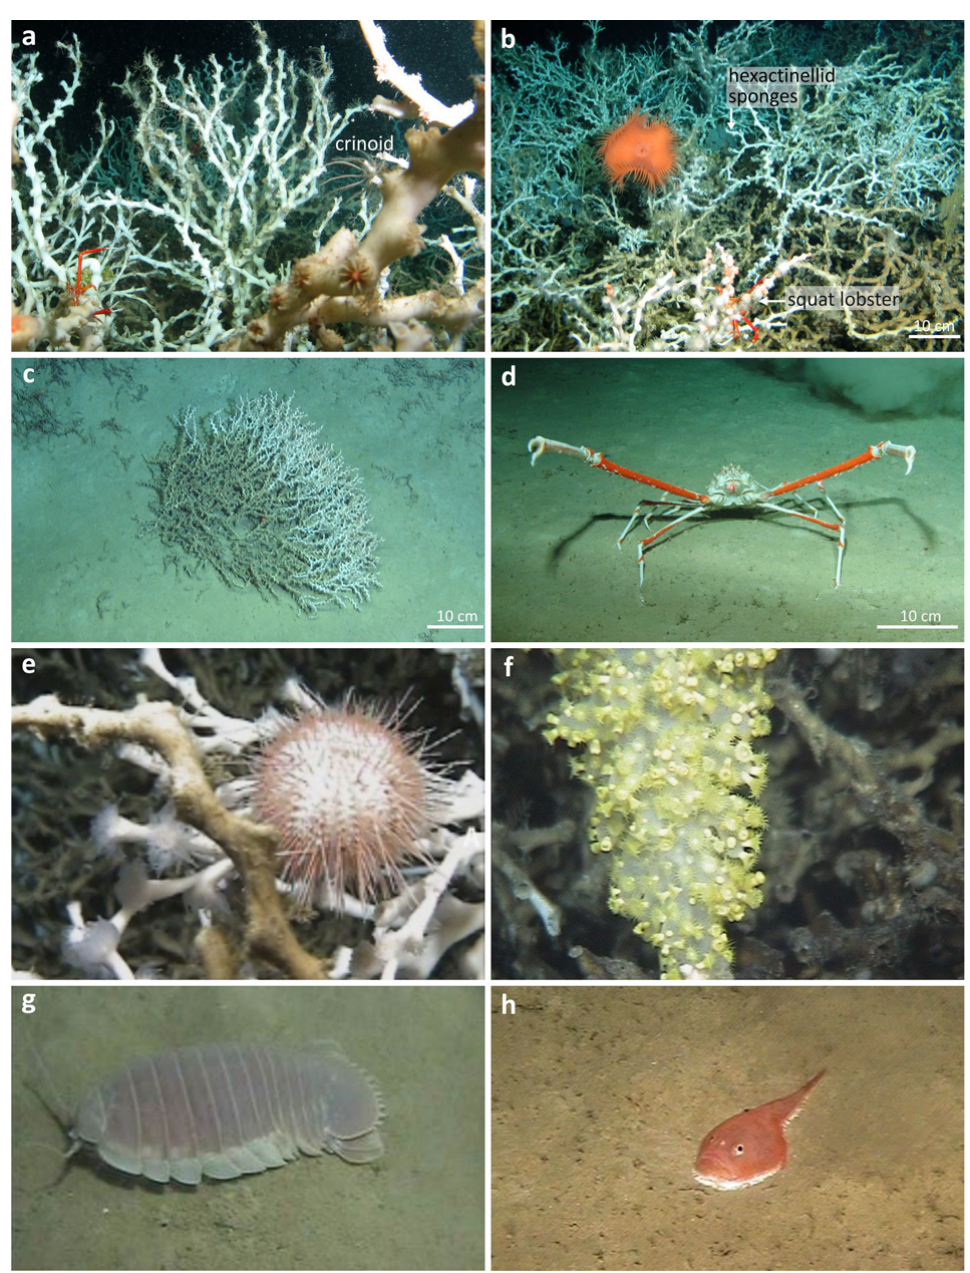
Fig. 4. ROV images showing examples for the megafaunal community present in the Campeche cold-water coral province (images copyright MARUM, Bremen, ROV Cherokee team). (a) Dense colonization of Lophelia pertusa at the coral mound top; (b) flytrap anemone (probably Actinoscyphia sp.) colonizing tissue-barren, exposed coral framework; (c) displaced but still alive colony of Enallopsammia profunda ; (d) brachyuran crab Rochinia crassa ; (e) grazing of living corals by the echinoid Gracilechinus sp.; (f) glass sponge Aphrocallistes sp. living together with masses of yellow actiniarians; (g) the giant cirolanid isopod Bathynomus giganteus ; and (h) the anglerfish Chaunax suttkusi commonly spotted near the coral mounds resting on the